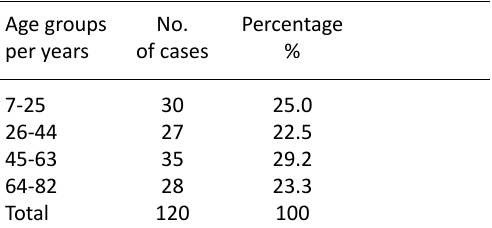
Table 2. Distribution of patients with cancer (n=120) by age group